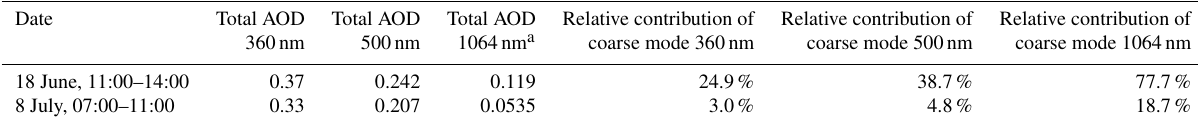
Table A27. Contributions of the coarse mode to the total AOD at different wavelengths derived from AERONET observations. The relative contributions are calculated assuming that the AOD of the coarse mode at 500nm (0.093 and 0.010 on 18 June and 8 July, respectively) does not depend on wavelength.